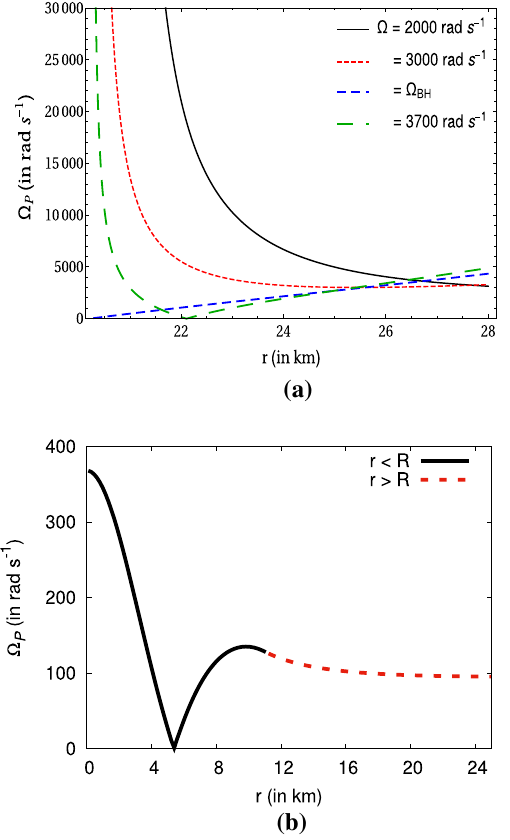
Fig. 8 Plots of the limiting values of Ω with distance from the center of a magnetized NS. The black solid curve and red short dashed curve are respectively for prograde and retrograde motion for non-magnetic case. The blue dashed curve and green dot dashed curve are repectively for prograde and retrograde motion around a magnetar with poloidal magnetic field with central magnetic field of 1 . 0 × 10 18 G . ω is zero for this case as we have considered a static star here. a Curves are from center to 2 km. b Curves are from 2 to 16 km